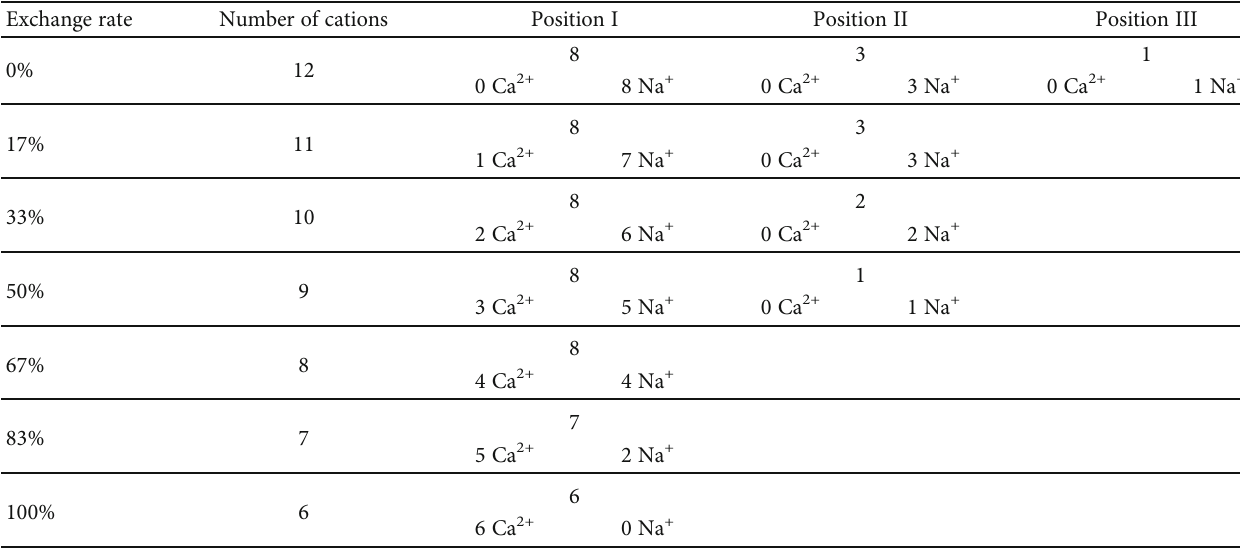
Figure 2: Schematic representation of cation positions I, II, and III according to [33]. Table 1: Theoretical cation distribution in LTA zeolites at di ff erent degrees of